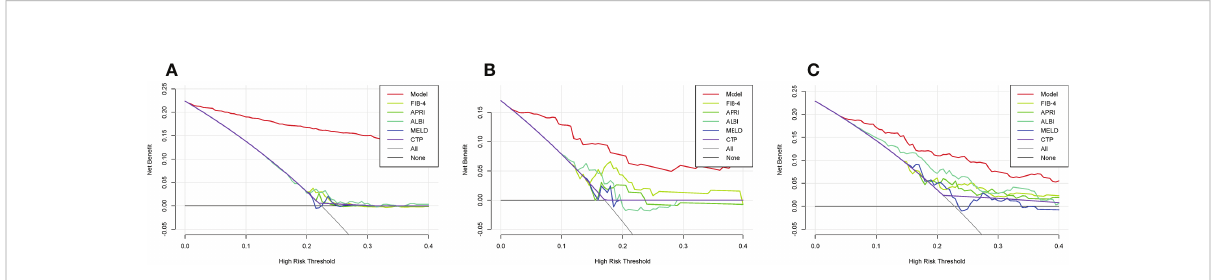
FIGURE 4 DCA curves. The DCA curves of the FIB-4 score, APRI score, CTP score, MELD score, and ALBI score are compared with that of the ML model in the training (A) , validation (B) , and testing (C) cohorts. sDCA, decision curve analysis; ML, machine learning; FIB-4, fi brosis-4; APRI, aminotransferase-to-platelet ratio index; CTP, Child-Turcotte-Pugh; MELD, model for end-stage liver disease; ALBI, albumin –